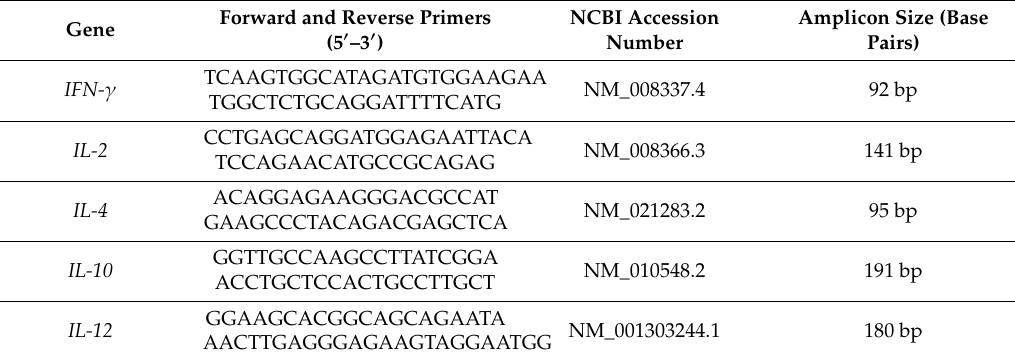
Table 1. List of forward and reverse primers used for real-time quantitative